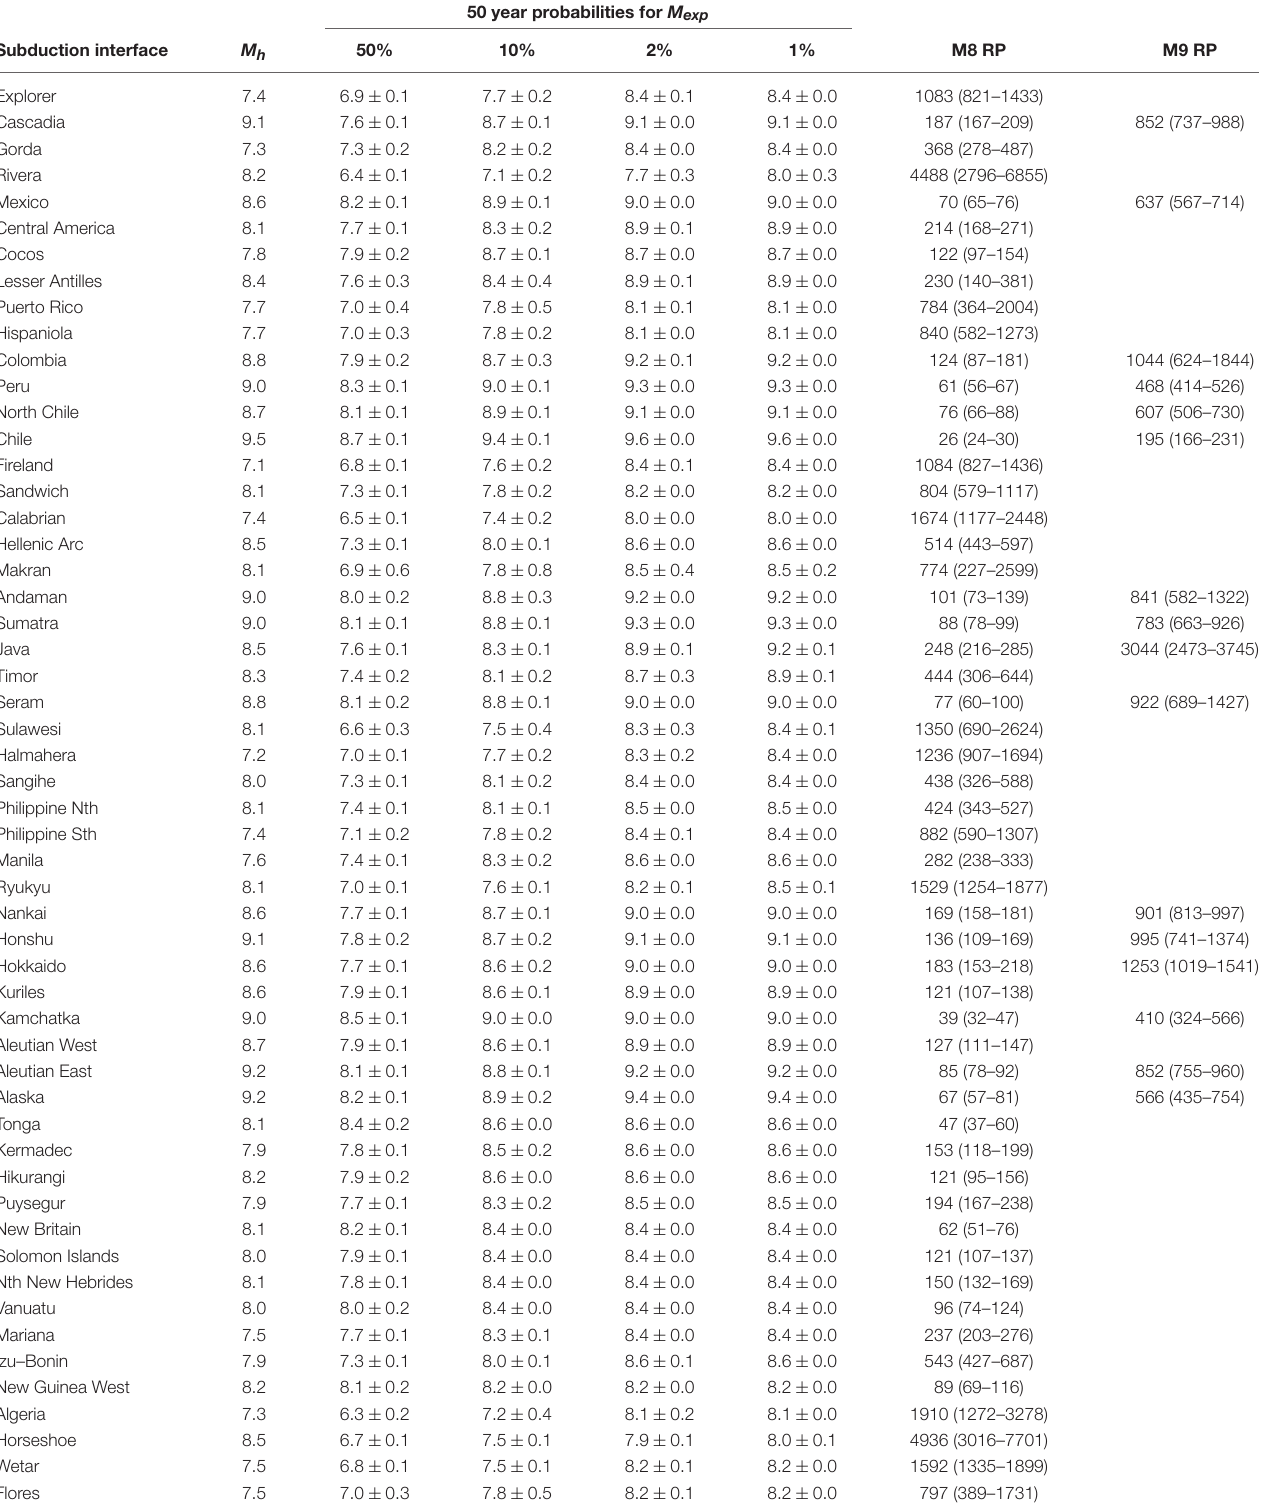
TABLE 6 | Overview of historic maximum magnitudes M h , M max , and M exp estimates for various time frames in regards of 50-year probabilities and respective return period (RP) results and for M w = 8 and 9. 50 year probabilities for M